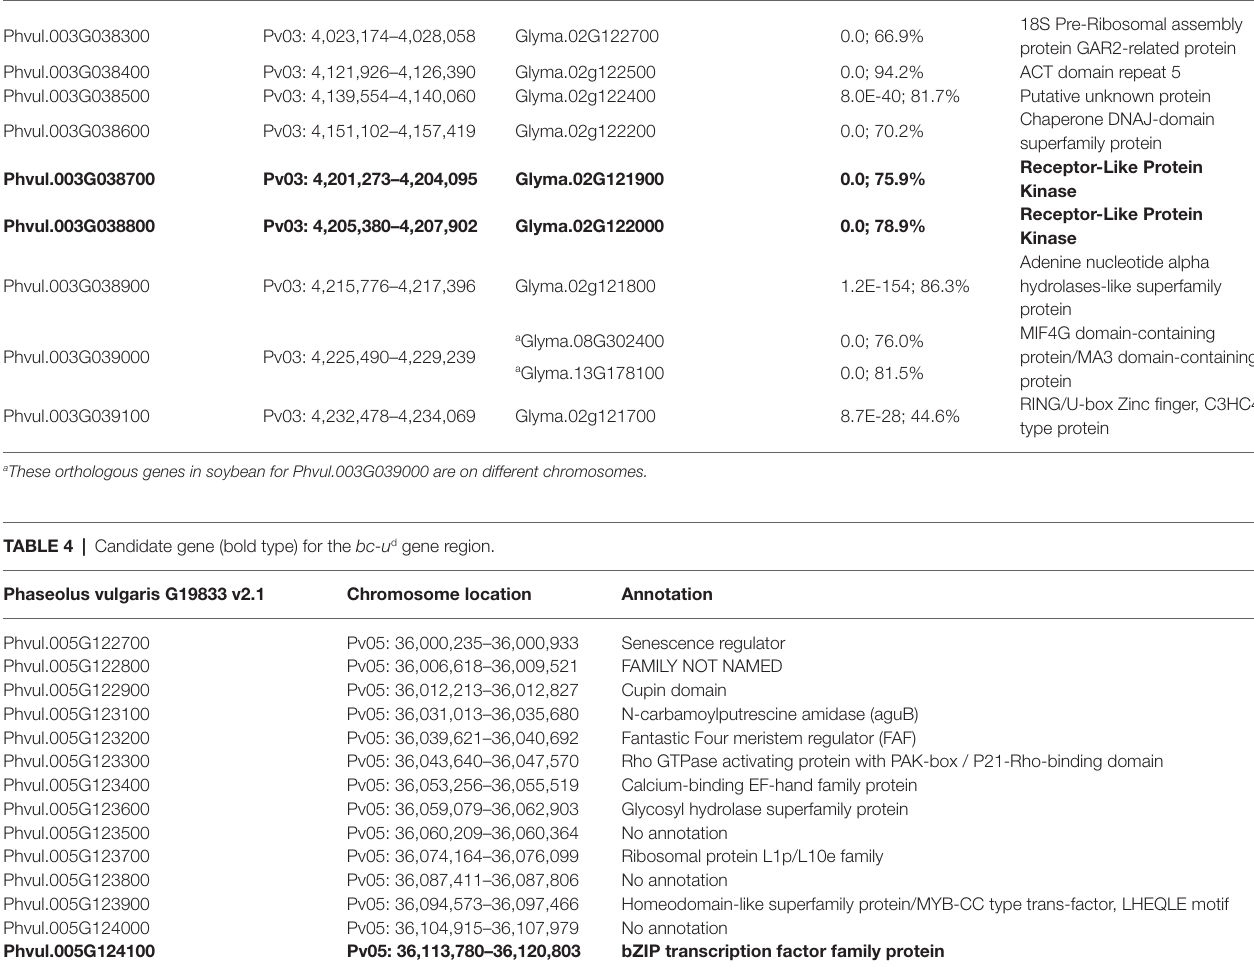
Phaseolus vulgaris G19833 v2.1